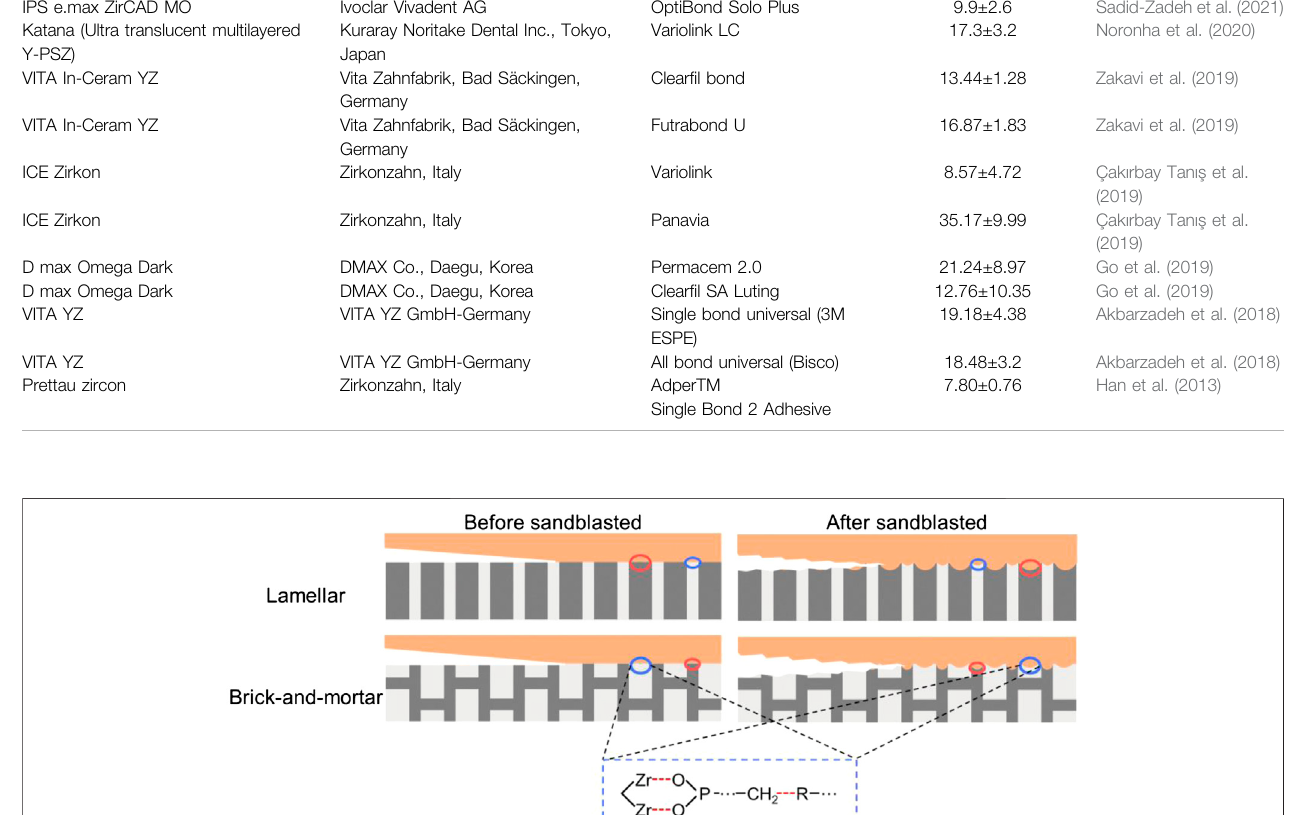
Frontiers in Bioengineering and Biotechnology |